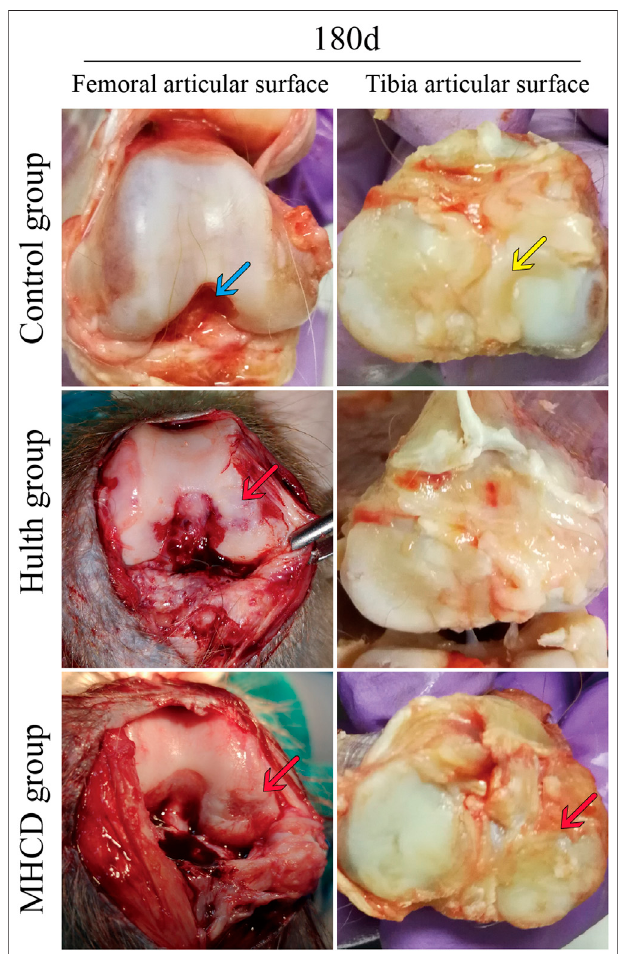
FIGURE 6 | Gross observations on Day 180, showing abrasion of the weight-bearing surface of the medial femoral condyle and femoral posterior condylar cartilage in the Hulth group, but more serious abrasion in the MHCD group (blue arrows, ACL; yellow arrows, medial meniscus; red arrows, cartilage